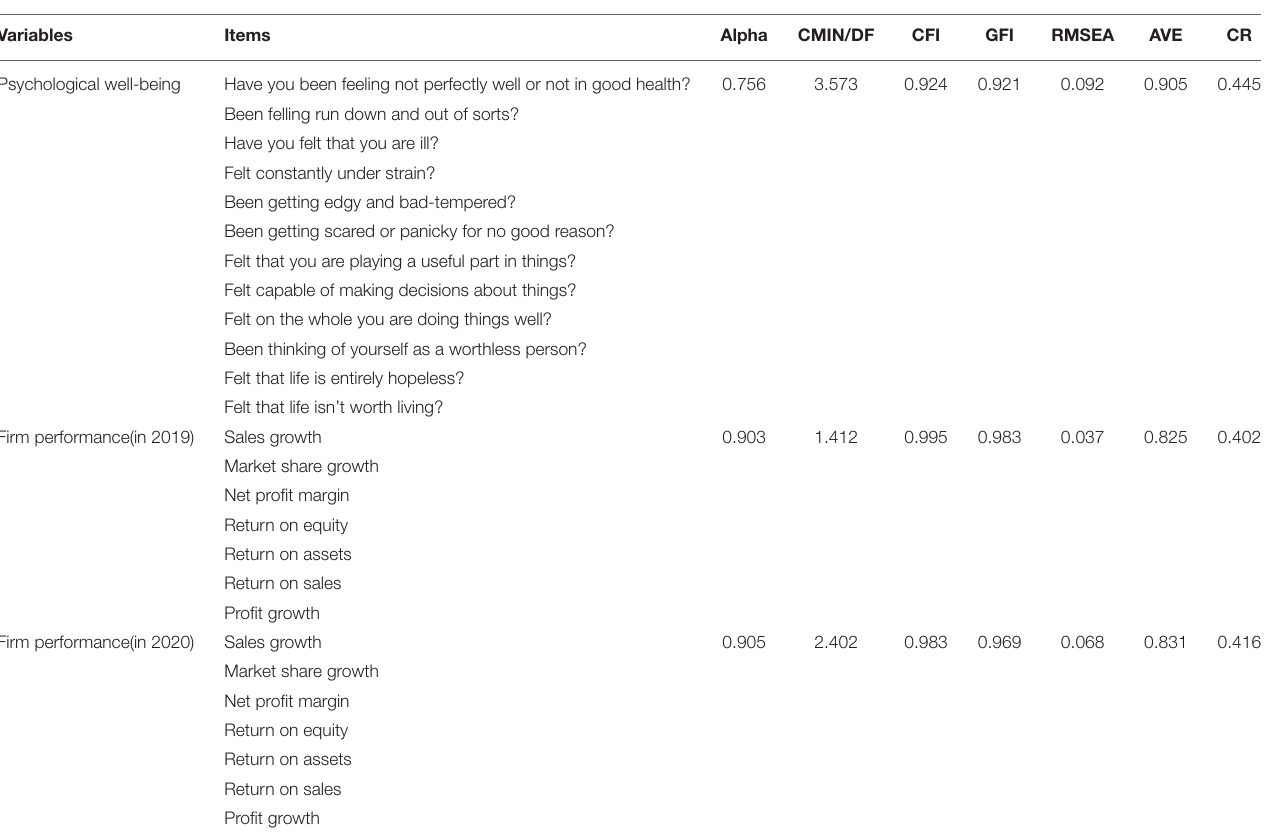
TABLE 1 | Measurement items and reliabilities.